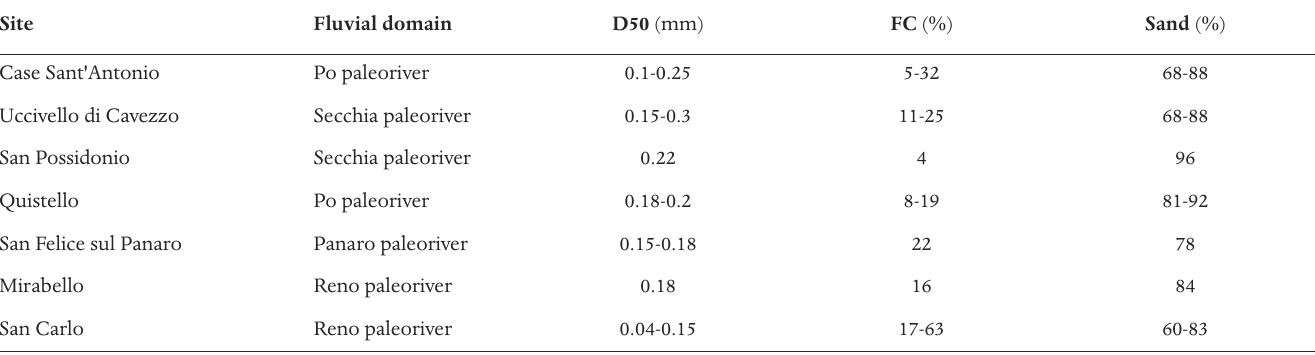
Table 1. Granulometric characteristics of the liquefied soils. FC, materials that pass through a number 200 sieve ASTM; D50, mean grain